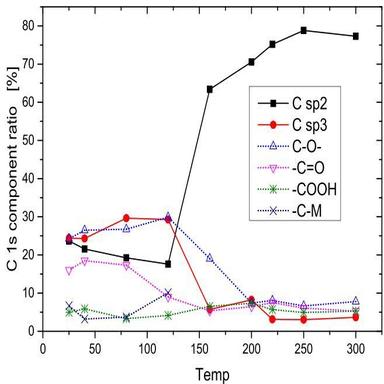
The fraction of C1s spectrum components obtained for GO annealed at different temperatures.